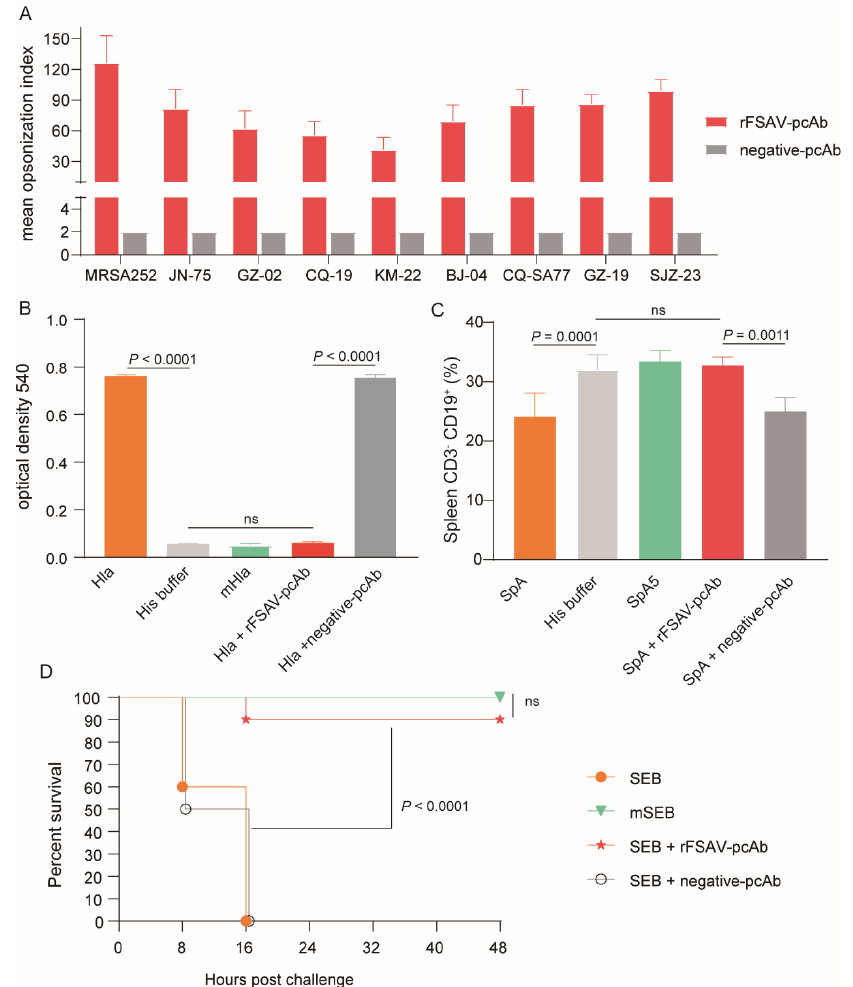
Figure 5. Analysis of rFSAV-pcAb’s efficacy on promoting opsonophagocytosis and neutralizing toxins. ( A ) Comparative analysis of opsonophagocytic killing activity against di ff erent clinical isolations of S. aureus by rFSAV-pcAb. The mean opsonization index was calculated to determine killing activity. The data were shown as the mean ± SD derived from three independent experiments. ( B – D ) Hla, SpA or SEB were incubated with rFSAV-pcAb or negative-pcAb at 37 °C for 30 min prior to the start of the study, respectively. ( B ) Hemolytic activity assay. 1% Rabbit erythrocytes were incubated with Hla pre-incubated with rFSAV-pcAb or negative-pcAb at 37 °C for 30 min. The supernatant containing hemoglobin was measured spectrophotometrically at 540 nm to detect the hemolytic activity. The data were shown as the mean ± SD derived from three independent experiments. The p -values were calculated using one-way ANOVA (ns = no significance). ( C ) B cell superantigen activity assay. CD3 − CD19 + B cells in splenic tissue of BALB / c mice ( n = 5) treated with SpA pre-incubated with rFSAV-pcAb or negative-pcAb were quantified by FACS. The data were shown as the mean ± SD, and the p -values were calculated using one-way ANOVA. ( D ) Intestinal toxin activity assay. mice were injected i.p. with D-Galactosamine (200 mg / mL) followed by an intramuscular injection with SEB pre-incubated with rFSAV-pcAb or negative-pcAb. The survival rates were recorded every 8 h over a 2-day observation period post challenge. The Mantel-Cox log-rank test was used to calculate p-